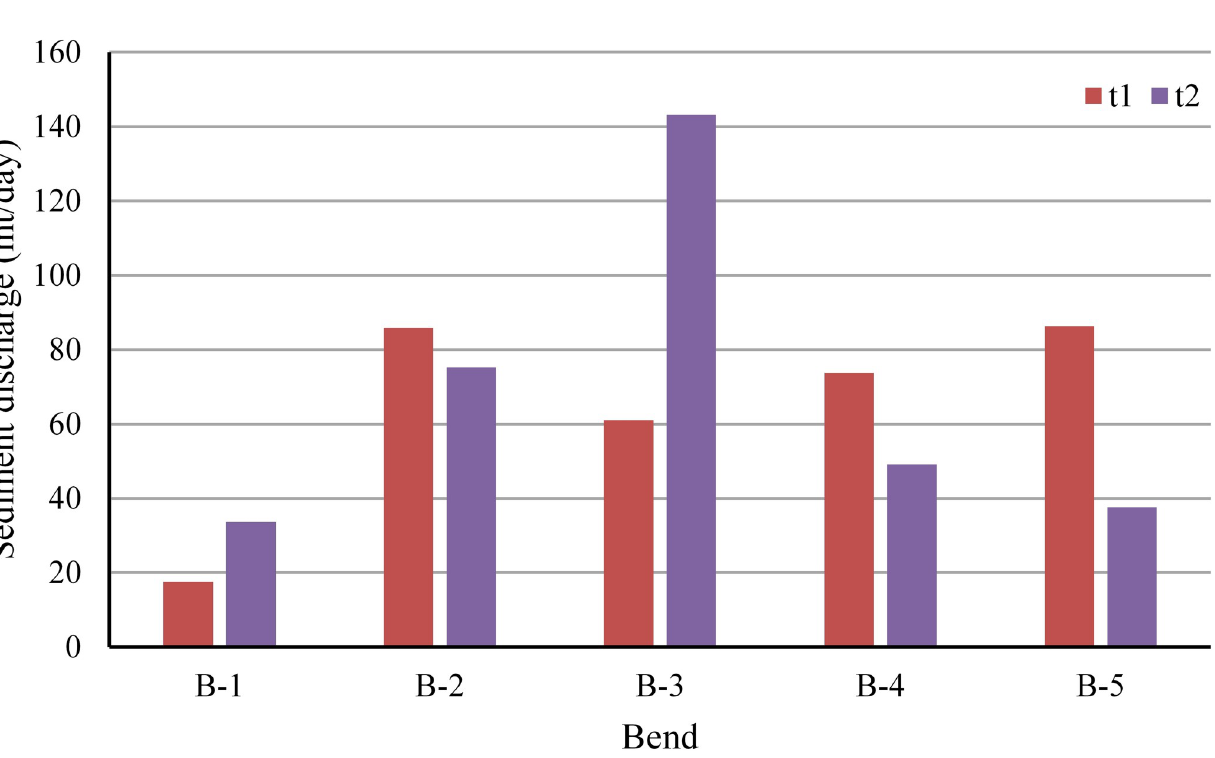
Fig 18. Suspended sediment discharge in the selected